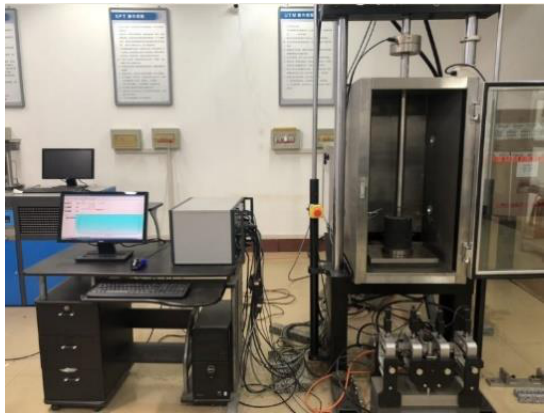
Figure 2. Uniaxial penetration test